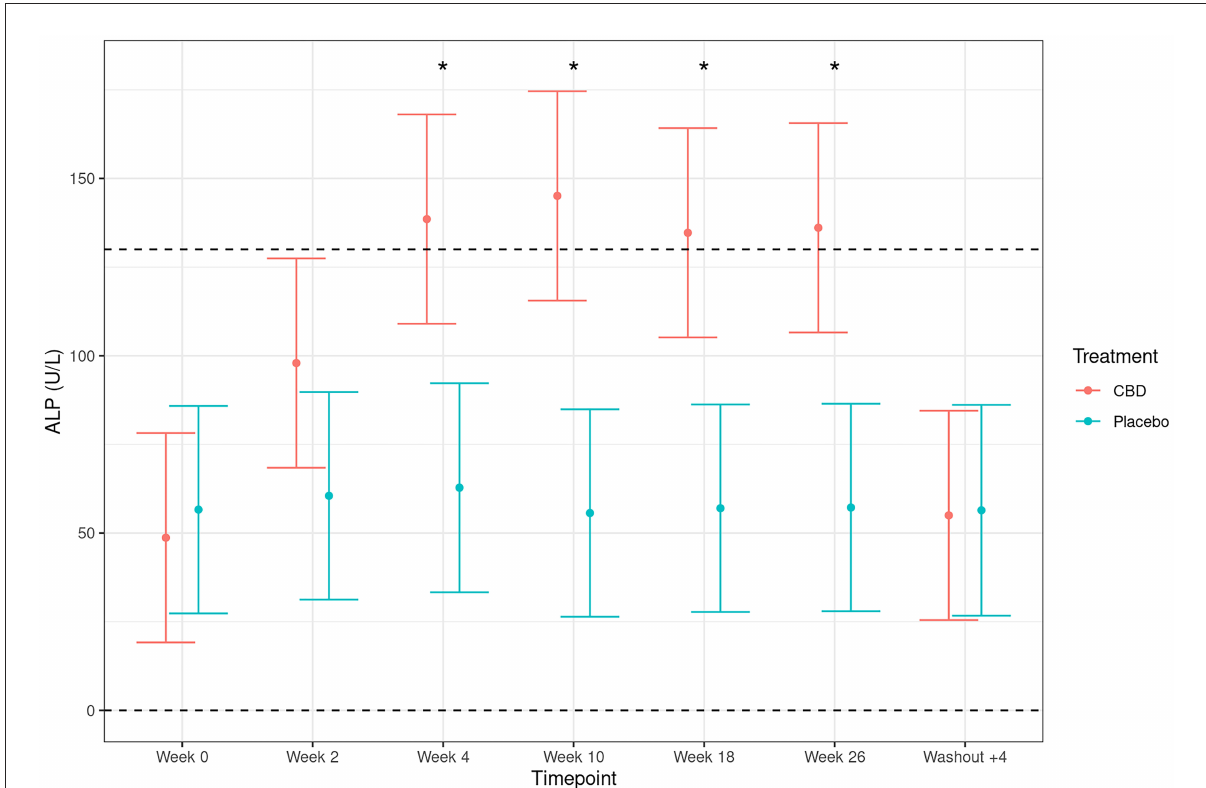
FIGURE2 Plasma activity levels of total alkaline phosphatase (ALP; U/L; mean and 95% confidence intervals) in dogs dosed with CBD (red) and placebo (blue). Week 0 depicts the baseline measure before daily oral dosing of CBD/placebo. Dotted line depicts upper and lower reference ranges as specified by IDEXX Laboratories. *Depicts significant differences between the experimental groups ( p <